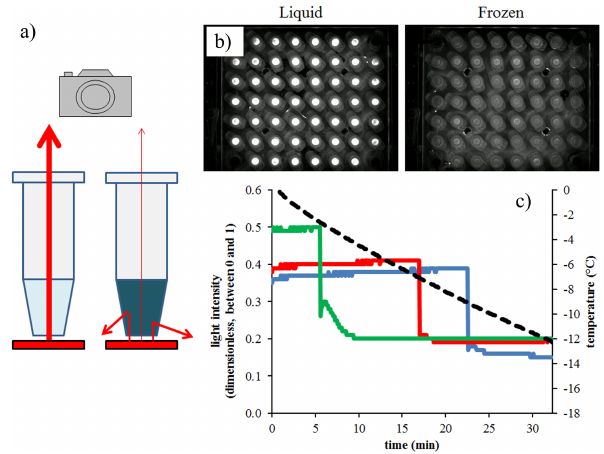
Fig. 4. Evolution of freezing temperature of 208 tubes filled with 200µL of snow water and stored at + 4 ◦ C. Tubes were analysed on the day of snow sampling (day 0) and 1, 7, and 30 days later. They were ranked by freezing temperatures on day 0 and this rank was allocated as a tube identity number for the rest of the trial. Freez- ing temperatures were determined between 0 ◦ C and − 12 ◦ C. Points were coloured according to different behaviours of associated tubes: black for those not frozen at or above − 5 ◦ C and not doing so the next time they are analysed; red for those not frozen at or above − 5 ◦ C, but which do so the next time they are analysed; green for those frozen at or above − 5 ◦ C during the current or one of the pre- vious